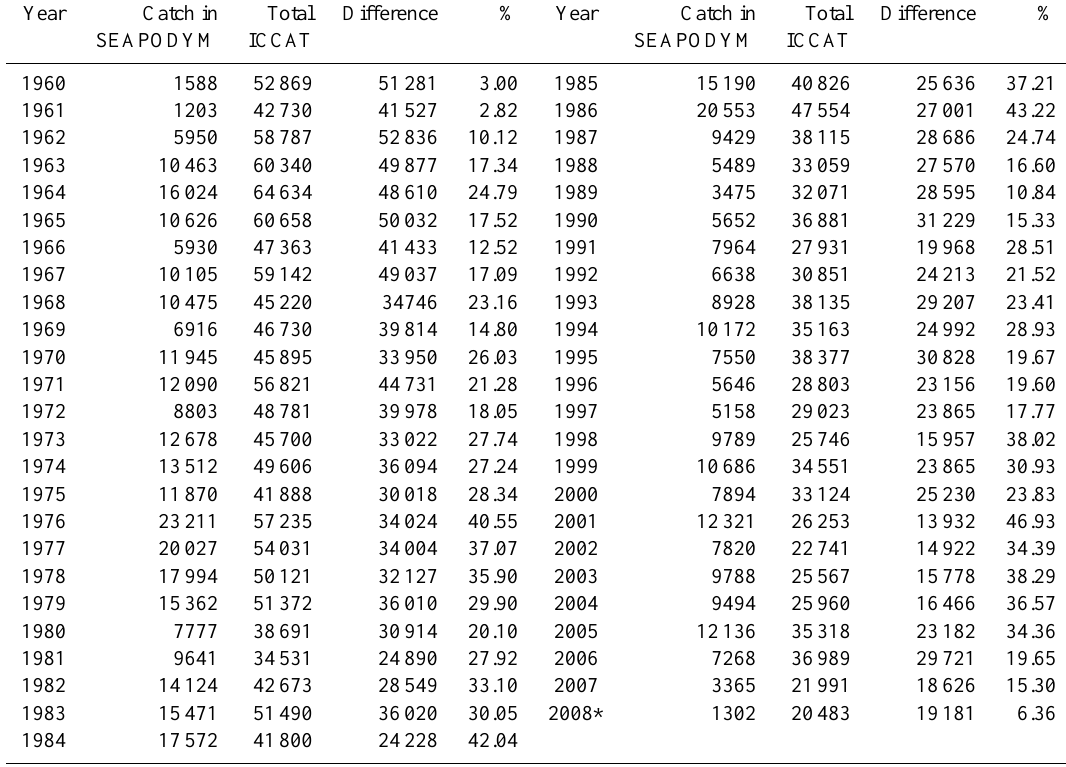
Table 1. Total annual catch 1960–2008 (tonnes) used in SEAPODYM North Atlantic albacore simulation compared with total annual catch by all fisheries declared in the ICCAT database. Difference in tonnes and corresponding percentage of